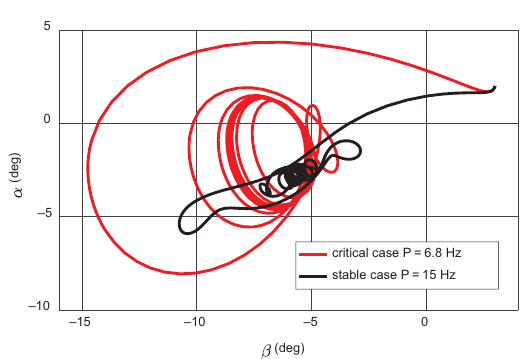
Figure 16. Diameter of limit cycle in critical and nominal roll rate for real ON-OFF